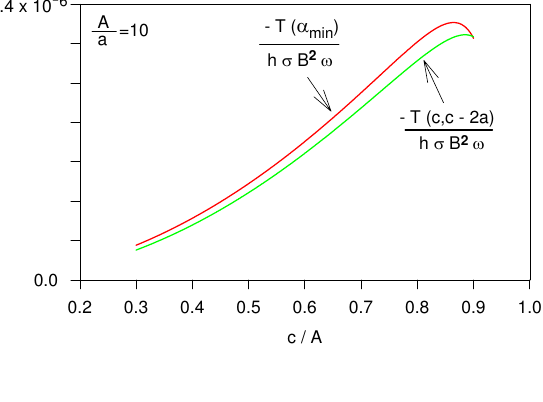
Figure 3: Braking factors − T nn /hσB 2 − T nk ( α min ) /hσB n B k ω and − T nk ( c, c − 2 a ) /hσB n B k ω